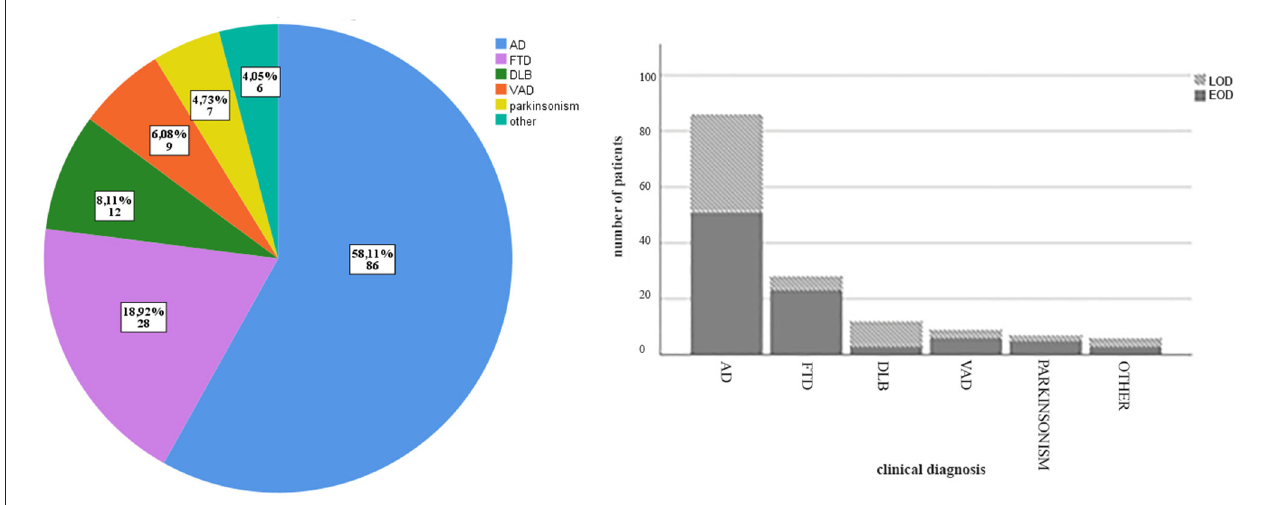
FIGURE 1 | Clinical diagnosis distribution. On the left, clinical diagnosis subgroups in the whole cohort represented by frequency and number of each diagnosis; on the right, clinical diagnosis distribution for EOD and LOD separately.